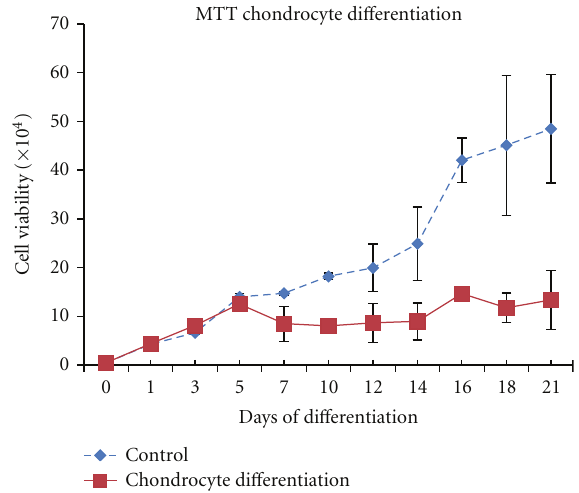
Figure 4: Cell viability by using MTT assay. The results were presented as mean ± SD. Statistical analysis was conducted by t - test. Comparison of data between controls and groups showed significant di ff erence after 14 days onwards ( P < 0 . 05; n = 3).